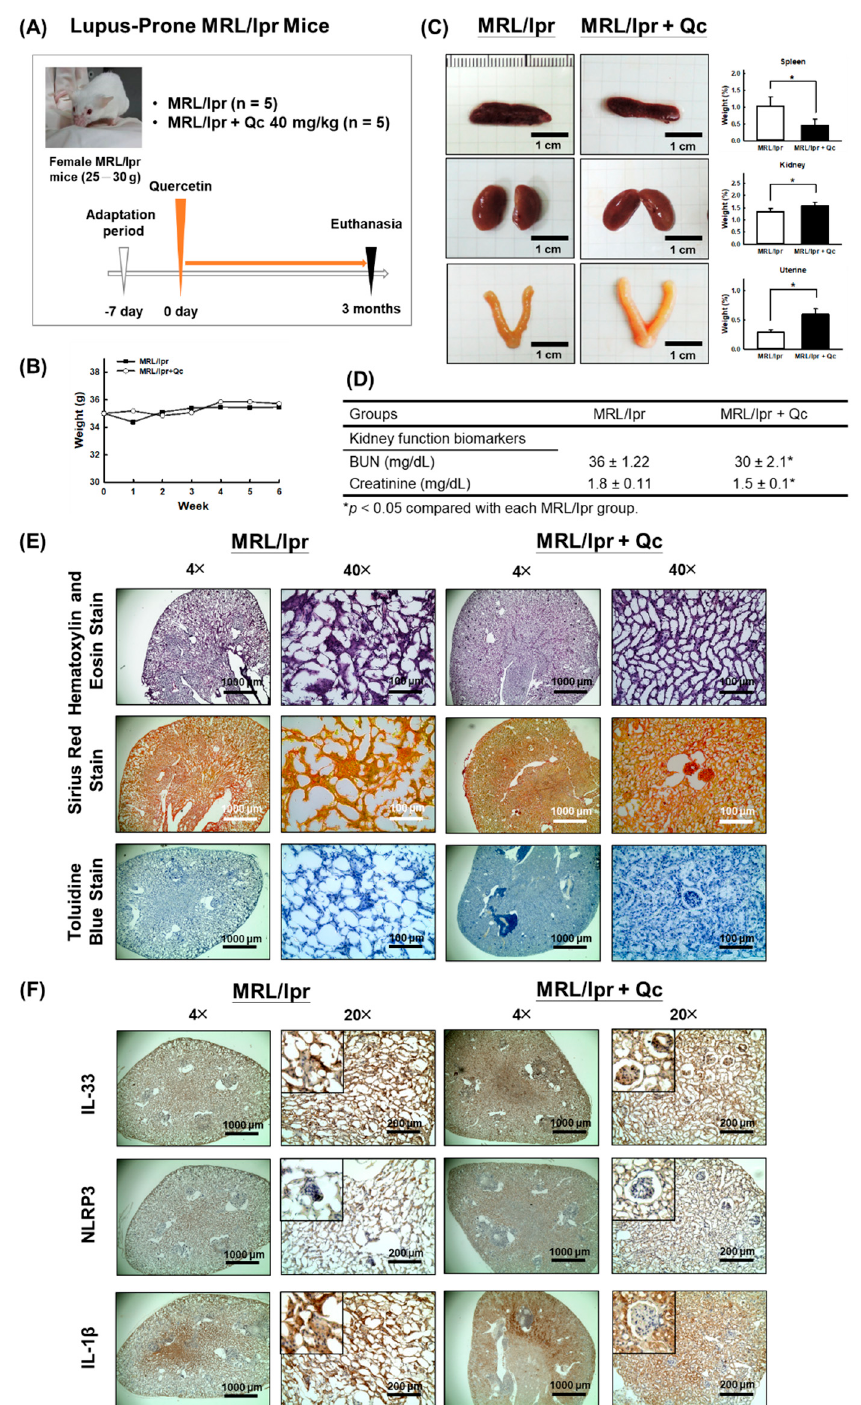
Figure 1. Quercetin ameliorated the renal pathology in MRL/lpr mice. ( A ) In vivo experimental procedure. ( B ) Body weight change in MRL/lpr mice. ( C ) Changes in appearance and weight of spleen, kidney, and uterus in MRL/lpr mice. ( D ) Determination of BUN and plasma creatinine concentration. ( E ) Renal tissue specimen stained with hematoxylin and eosin stain, Sirius Red stain, or Toluidine Blue stain for MRL/lpr mice that were given either vehicle (ddH 2 O) or quercetin for 3 months. Magnification, 40 × and 400 × . ( F ) Representative photomicrographs of the expression and distribution of IL-33, NLRP3, and IL-1 β in renal tissues in MRL/lpr mice using immunohistochemical staining. Magnification, 40 × and 200 × . Data were expressed as mean ± SD for each group. * p < 0.05 versus untreated MRL/lpr mice ( n =